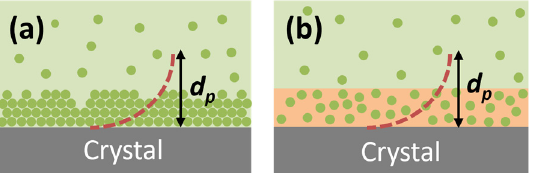
Scheme 1. Schematics of the protein (the green spheres) adsorption on the blank ( a ) and PEM-coated ( b ) crystal. The dashed line represents the evanescent wave characterized by a penetration depth d p . The scheme illustrates the different character of Lys adsorption on the blank and PEM-coated crystal and is not to scale. In reality, Lys does not have a spherical but rather an ellipsoidal shape, and it may form less homogeneous layers than presented in ( a )